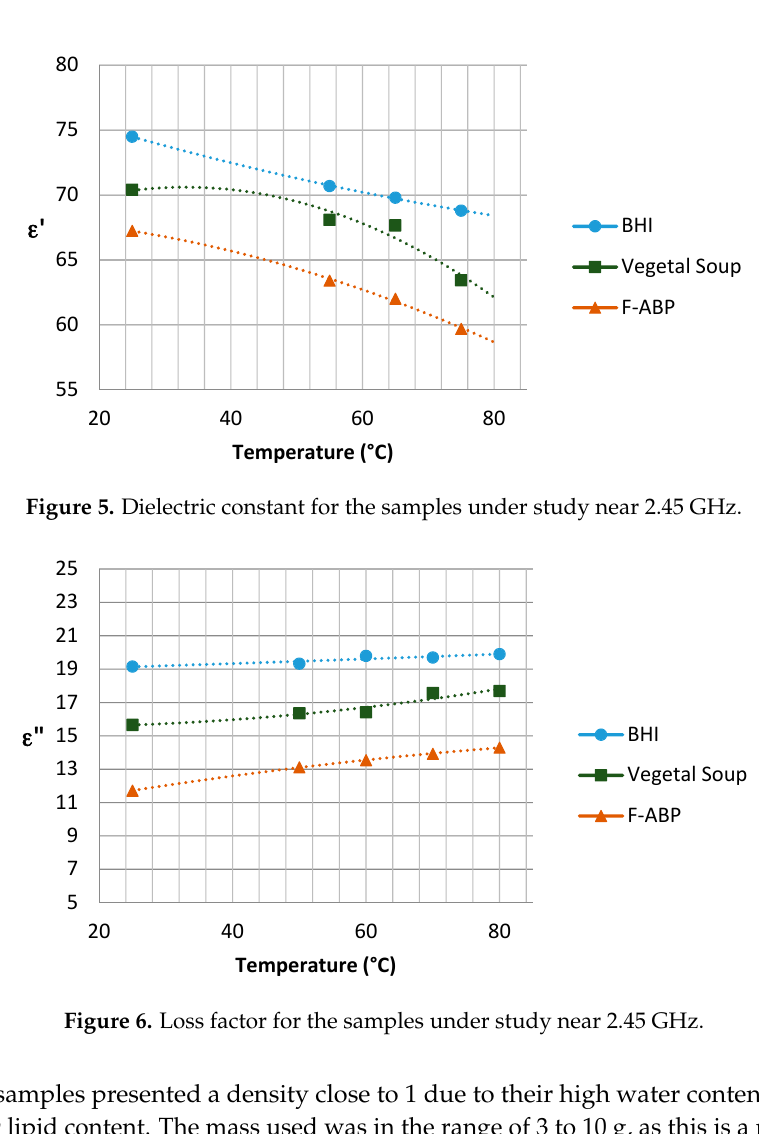
Figure 6. Loss factor for the samples under study near 2.45 GHz.